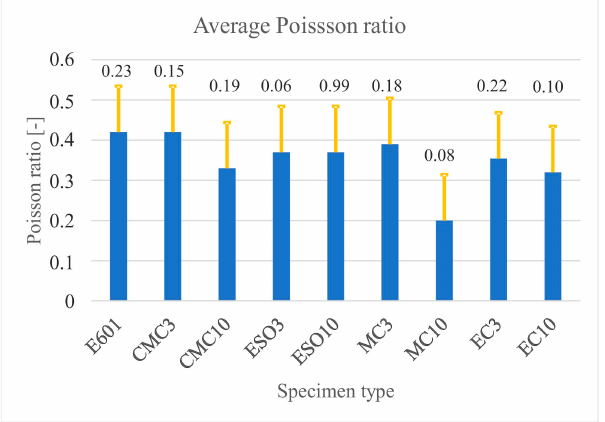
Figure 8. Average values of Poisson’s ratio with standard deviation bars as a function of the specimen type.